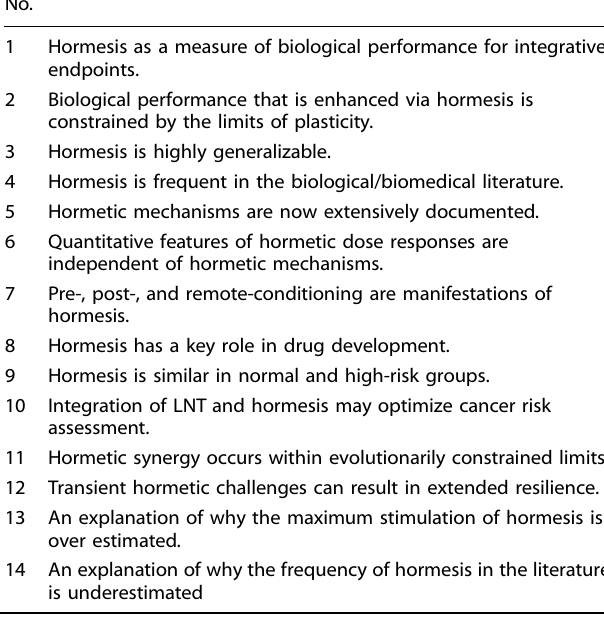
Table 1. Hormesis conceptual re fi nements since the year 2000